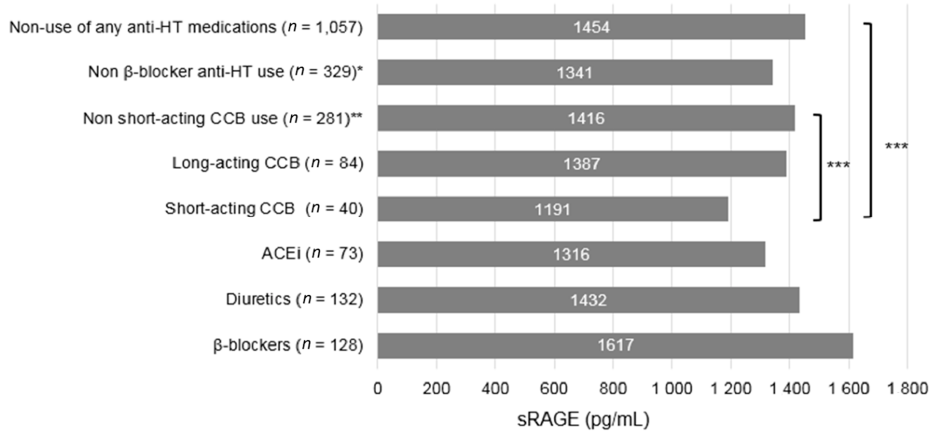
Figure 1. Average serum sRAGE level by anti-HT medication use among controls in the WHI Study ( n = 1388). ACEi = Angiotensin converting enzyme inhibitor; CCB = Calcium channel blocker; DHP = Dihydropyridine; NDHP = Non-dihydropyridine; sRAGE = soluble receptor for advanced glycation end products. * Including ever use of ACEi, diuretics, or CCB. ** Including ever use of ACEi, diuretics, β -blockers, or long-acting CCB. *** p < 0.05, Sidak multiple comparison adjustment applied to compute p -value based on model adjusted for age at baseline, BMI (<25, 25–< 30